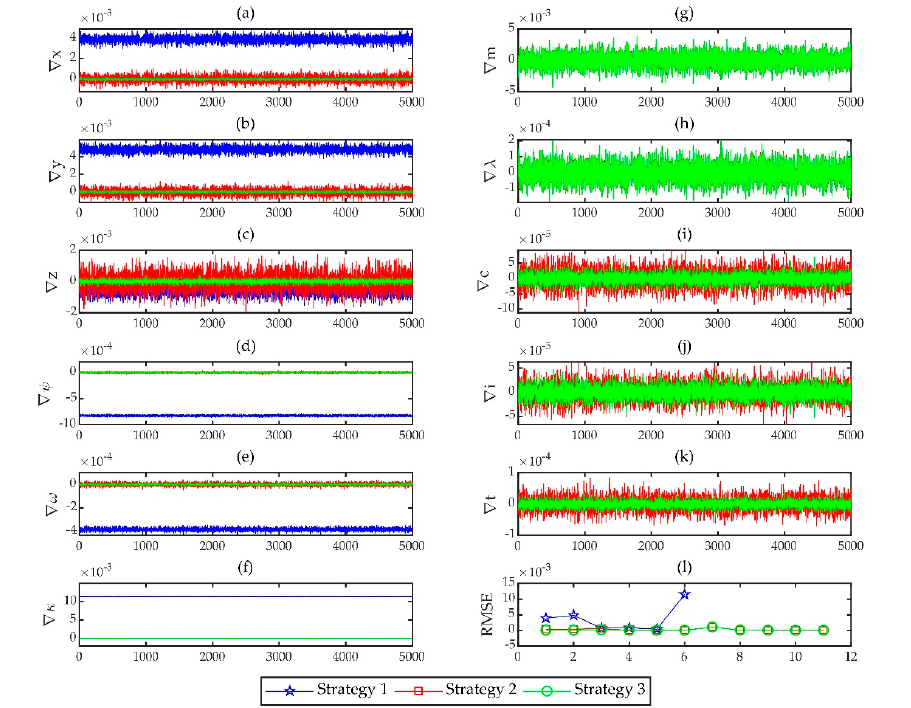
Figure 4. The di ff erence in the sequences of the parameters in Case 1 with its RMSE where the horizontal Figure 4. The difference in the sequences of the parameters in Case 1 with its RMSE where the axis indicates the experiment serial number from ( a ) to ( k ) and parameters’ serial number in ( l ). ( a ) ∇ x , horizontal axis indicates the experiment serial number from (a) to (k) and parameters’ serial number ∇ z ( b ) ∇ y , ( c ) ∇ z , ( d ) ∇ ϕ ,( e ) ∇ ω , ( f ) ∇ k , ( g ) ∇ m , ( h ) ∇ λ , ( i ) ∇ c , ( j ) ∇ i , ( k ) ∇ t , ( l ) RMSE of EOPs and ∇ x ∇ ω ∇ k ∇ m ∇ λ ∇ c ∇ i ∇ t in (l). ( a ) , ( b ) ∇ y , ( c ) , ( d ) ∇ φ ,( e ) , ( f ) , ( g ) , ( h ) , ( i ) , ( j ) , ( k ) , (l) RMSE of EOPs and Aps.